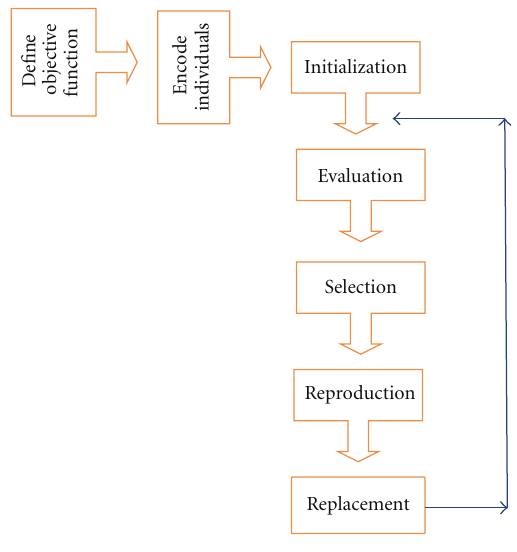
Figure 5: Process of a genetic